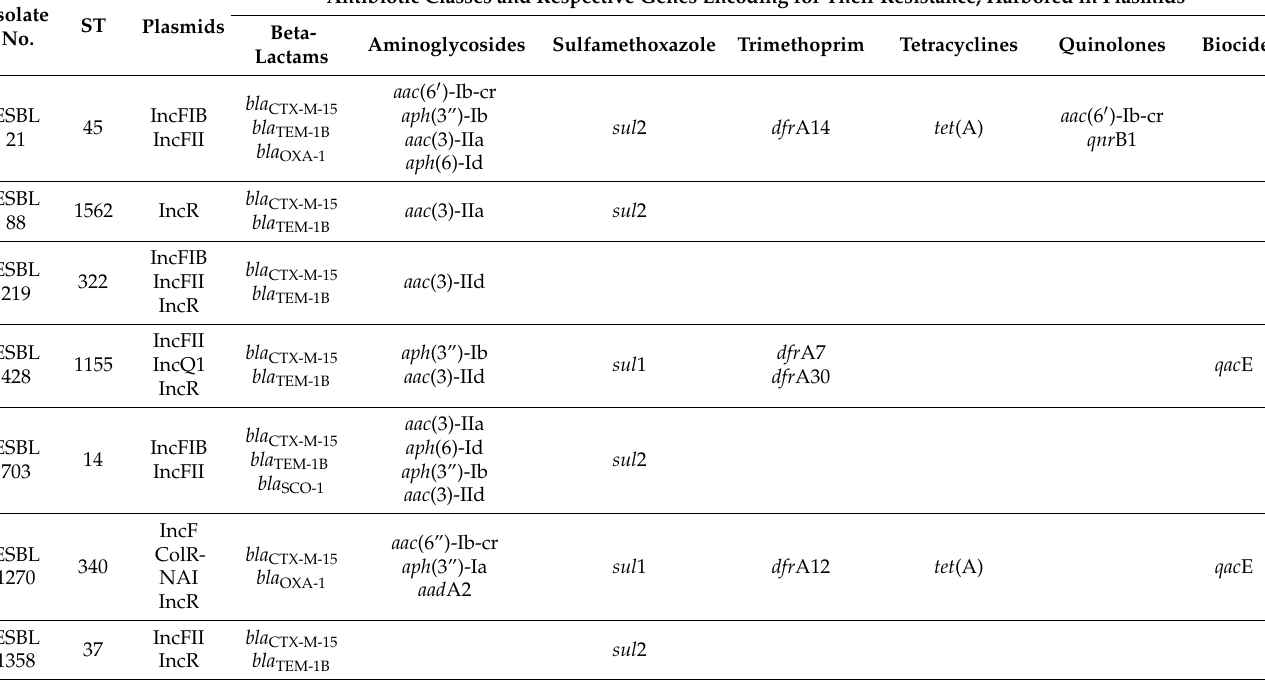
Table 3. Plasmids harboring genes encoding for antibiotics